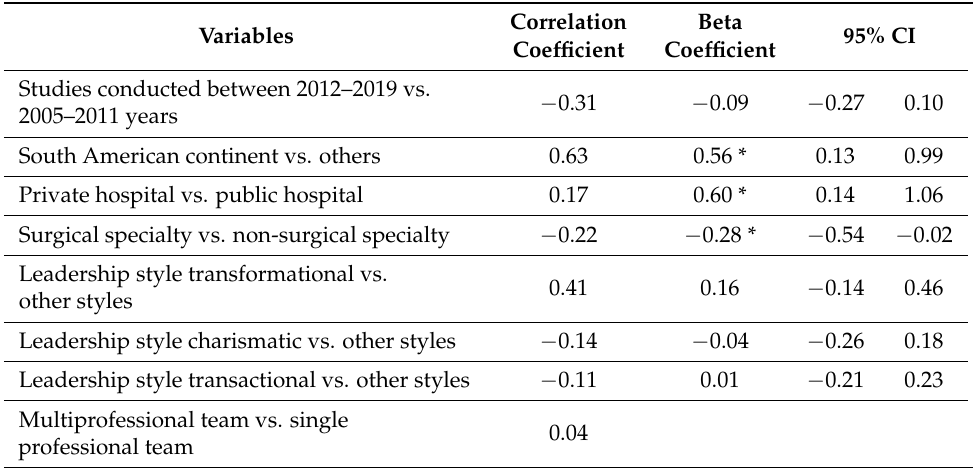
Table 2. Multi-regression analysis of leadership effectiveness in cross-sectional studies.